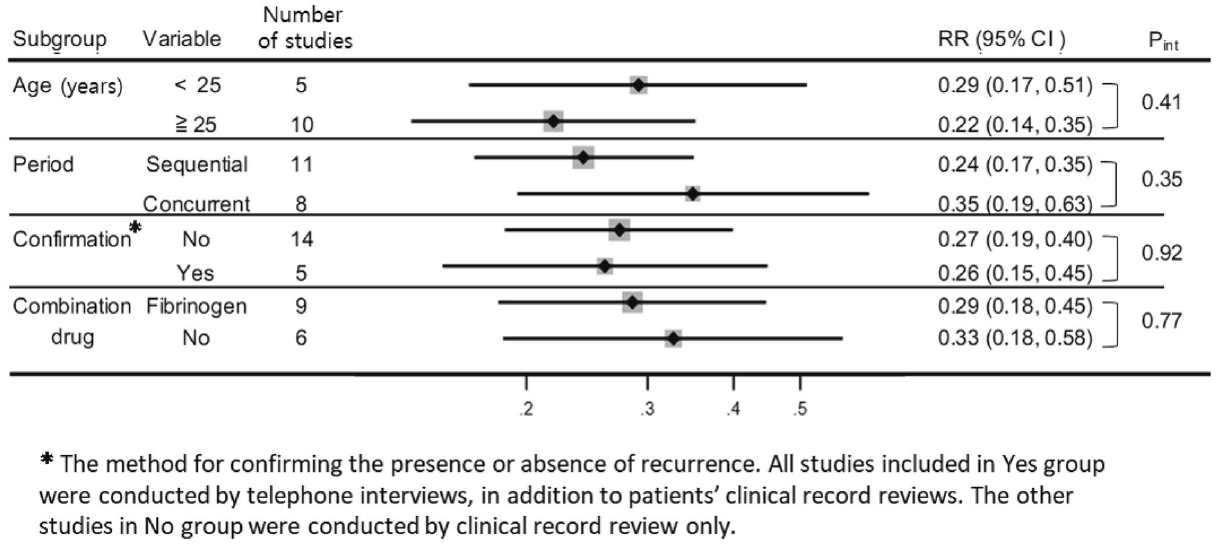
Figure 4. Subgroup analysis of the effect of the PGA covering. CI confidence interval, RR risk ratio, Pint P for